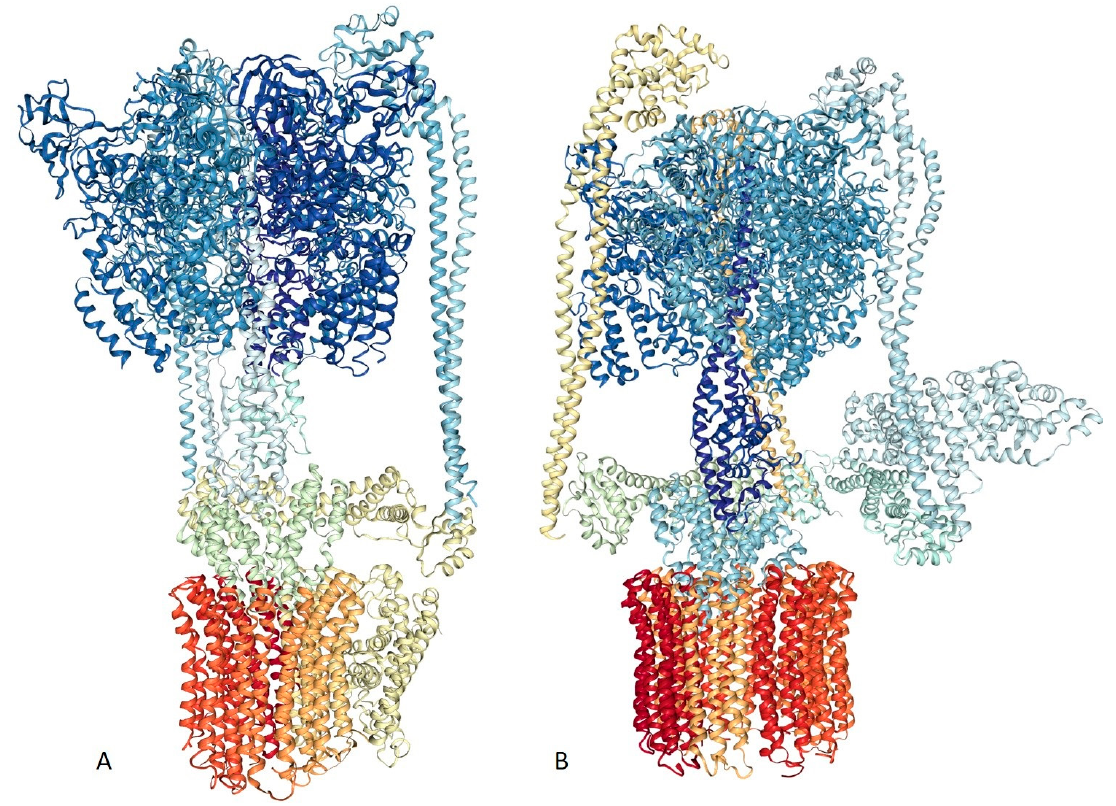
Figure 3. Single-particle cryo-EM-based structural characterization of the eubacterial and eukaryotic Figure 3. Single ‐ particle cryo ‐ EM ‐ based structural characterization of the eubacterial and eukaryotic vacuolar-type ATPases (V-ATPases) from Thermus thermophiles (( A ). PDB ID: 5GAR, [123]) and vacuolar ‐ type ATPases (V ‐ ATPases) from Thermus thermophiles ( A , PDB ID: 5GAR, [123]) and Int. J. Mol. Sci. 2019 , 20 , x Saccharomyces cerevisiae (( B ). PDB ID: 3J9T, [124]), respectively. Saccharomyces cerevisiae ( B , PDB ID: 3J9T, [124]), respectively.